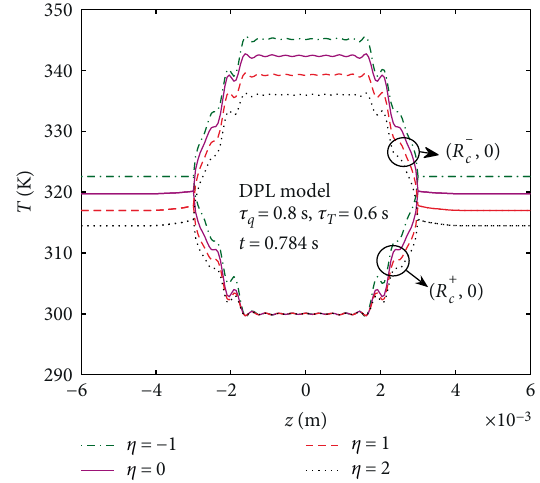
Figure 10: Effect of FG parameter on the temperature distribution along the crack plane based on the DPL